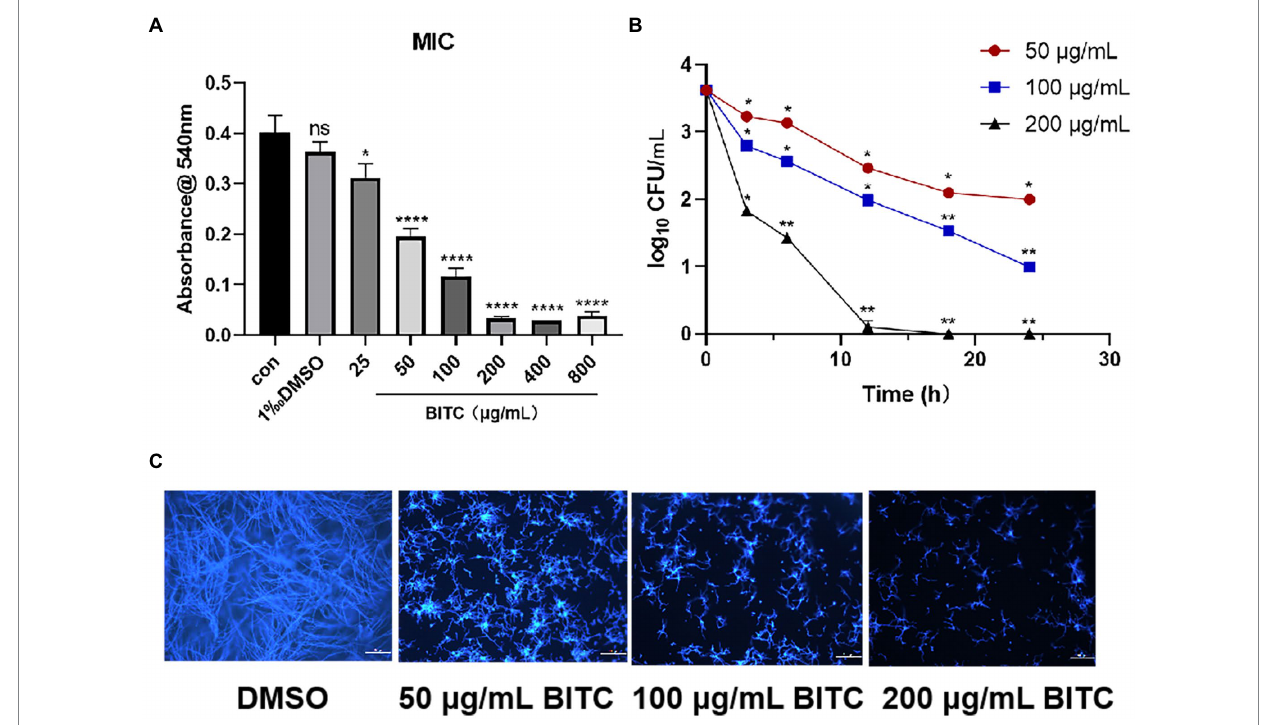
FIGURE 2 Fungicidal effect of BITC against A. fumigatus . The effect of BITC on growth and germination of A. fumigatus for 24 h (A) . Time-kill curves (B) for A. fumigatus exposed to BITC (50, 100 and 200 μ g/ml) at different time point (* < 2log10 CFU/mL, ** > 2log10 CFU/mL). Calcofluor white staining (C) showed surviving A. fumigatus hyphae under treatment with 0.1% DMSO and BITC (50, 100 and 200 μ g/ml), magnification ×200. Values represent as means ± SD (* p < 0.05, ** p < 0.01, *** p < 0.001, **** p <